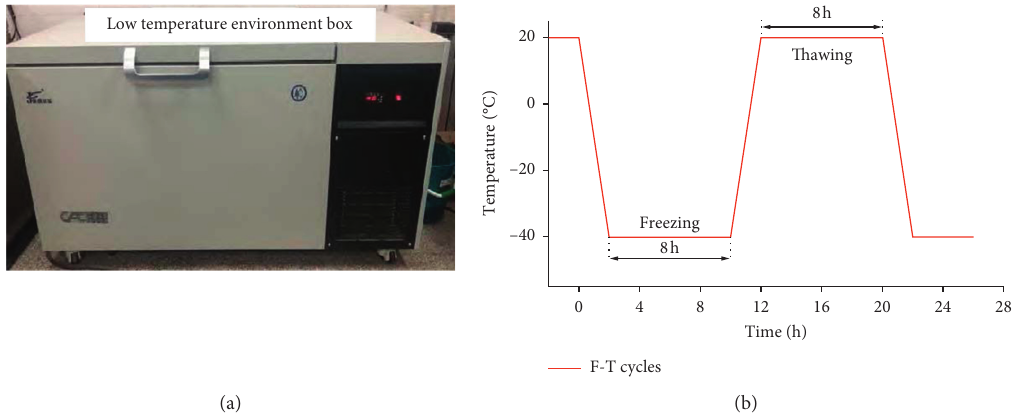
Figure 2: F-T treatment of specimens before the uniaxial compression test: (a) low temperature F-Tenvironment box; (b) the temperature diagram of